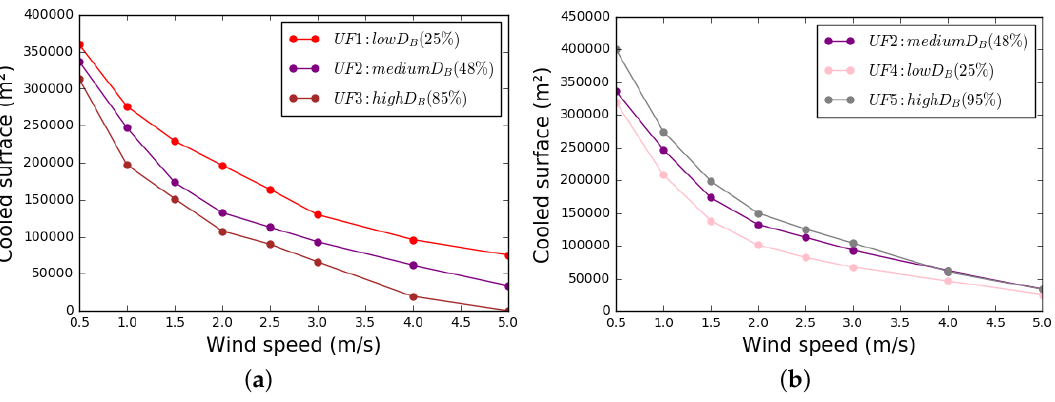
Figure 7. Influence of wind speed on the cooled surface for various building density values: ( a ) When building density was increased by modifying the building size; ( b ) When building density was increased by modifying the street width.